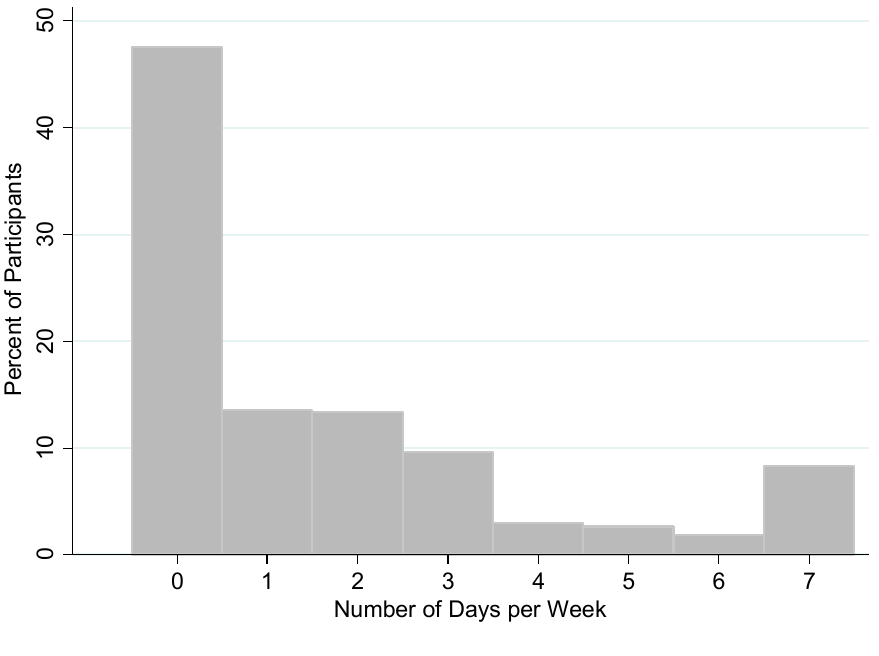
Figure 2. Weekly consumption of fried food among study participants. Table 4. Associations between sociodemographic characteristics and number of days per week consuming fried food among the study